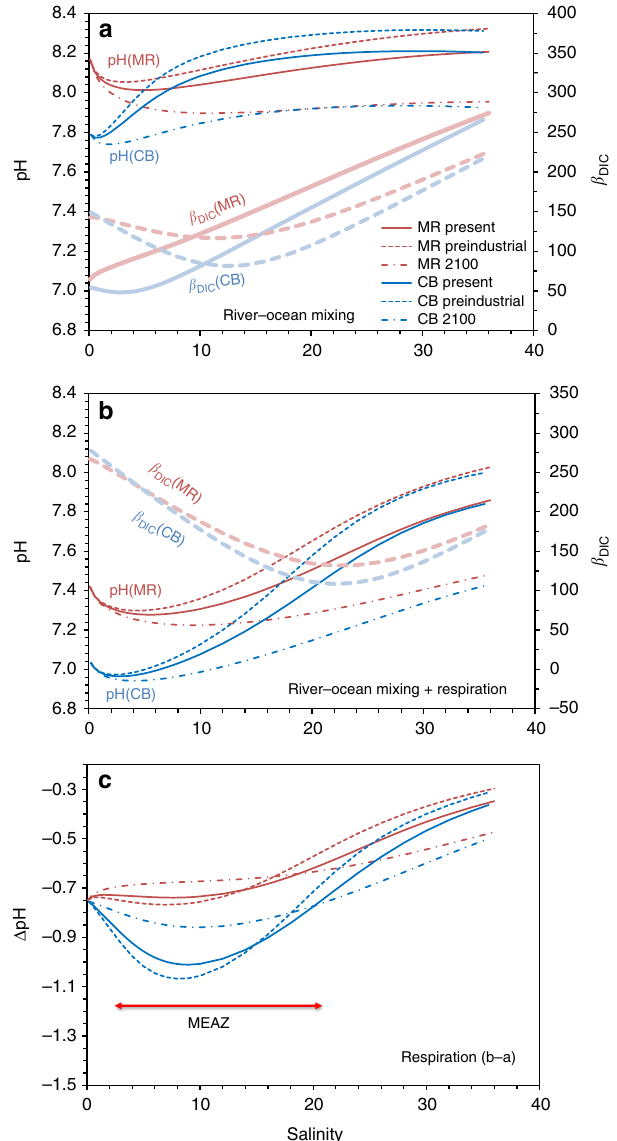
Fig. 5 Simulations of pH and pH decrease and the evolution of the buffer factor β DIC in Chesapeake Bay ( CB ) waters and Mississippi River ( MR ) coastal waters. a pH curves ( thin lines ) during estuarine mixing under three scenarios (preindustrial era, present day, and year 2100). Buffer factor β DIC for the present day condition ( thick solid lines ) and the present day condition plus 100 μ mol kg − 1 ( thick dashed lines ) are also presented for both estuaries. b pH curves and β DIC curves plus full O 2 consumption (respiration) during estuarine mixing. ( c ) pH decrease ( − Δ pH) as a result of full O 2 consumption during estuarine mixing (a difference between b and a ). The red arrows represents the Maximum Estuarine Acidi fi cation Zone ( MEAZ ).